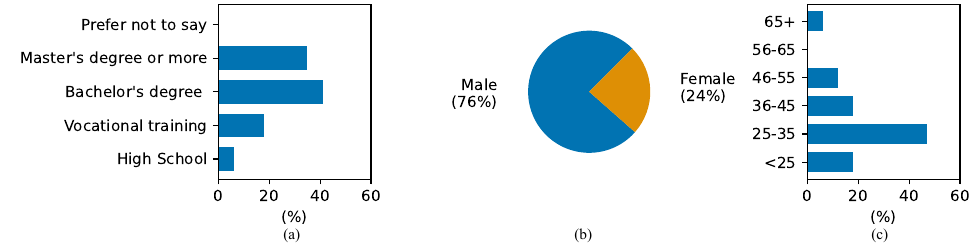
Figure 2. Socio-demographic characteristics of the 17 interviewees including ( a ) Highest education level, ( b ) Gender and ( c )